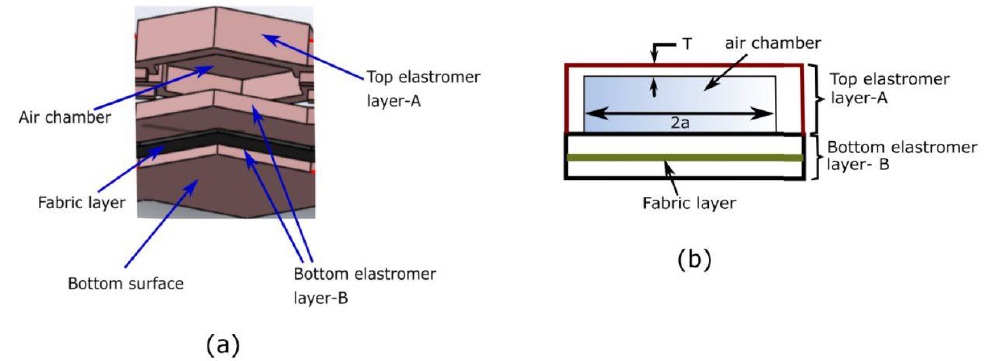
Figure 1. ( a ) The layered view of mini-bladder design, ( b ) schematic of the mini-bladder of consisting layers and the air